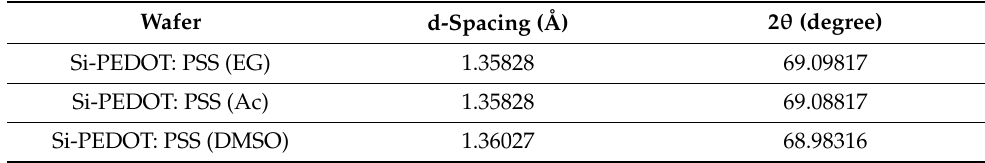
Table 2. d-spacing and 2 θ value calculated from XRD